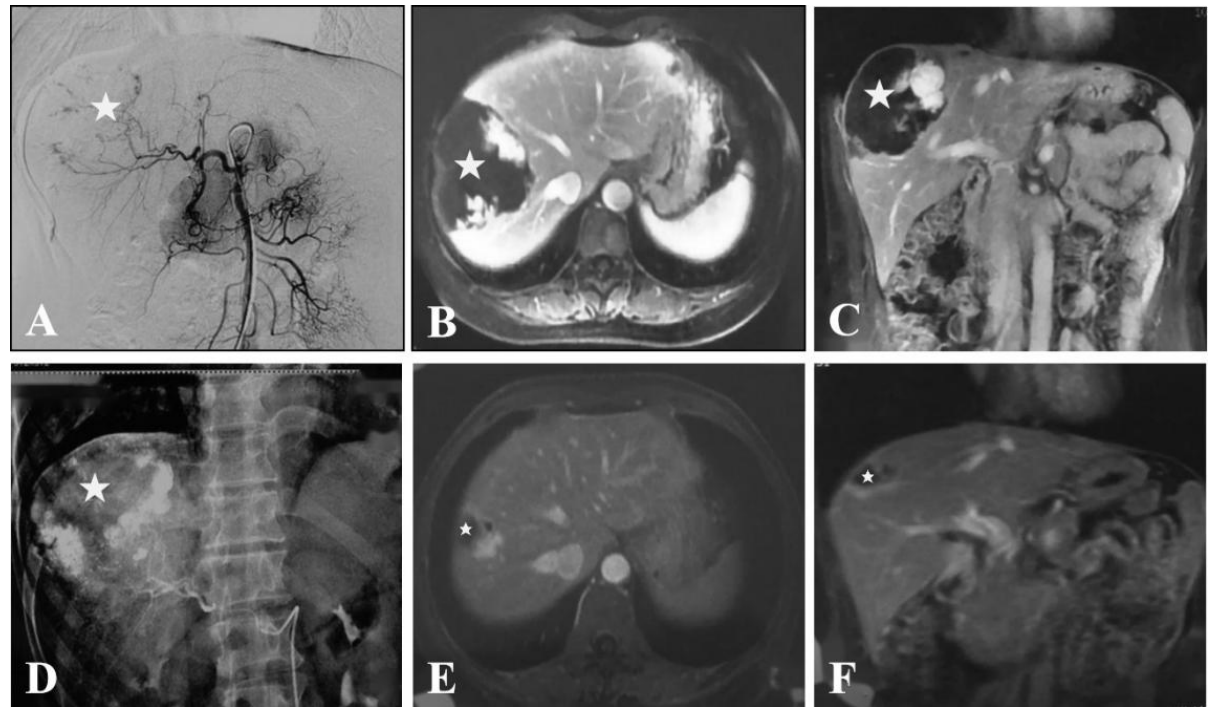
Values are presented as means ± standard deviations (SD) and ranges; TAE: transarterial arterial embolization.